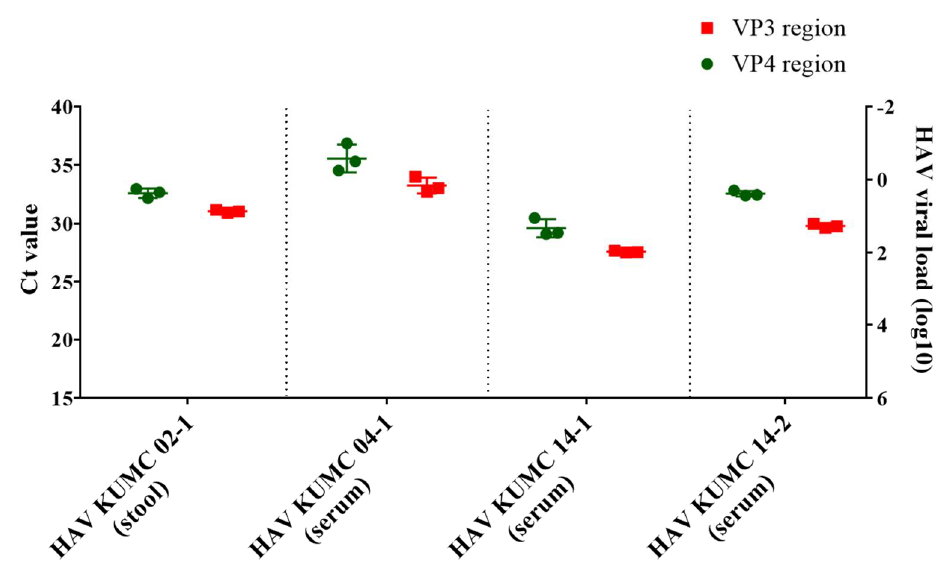
Figure 1. Quantitation of hepatitis A virus (HAV) RNA genome in clinical samples from patients in the Republic of Korea. Real-time quantitative polymerase chain reaction assay was performed for molecular diagnosis and quantification of HAV genomes in serum and stool samples. The vertical axis shows the HAV RNA copy numbers of VP4 and VP3 regions. Each data point represents the mean threshold cycle (Ct) value obtained from triplicates.